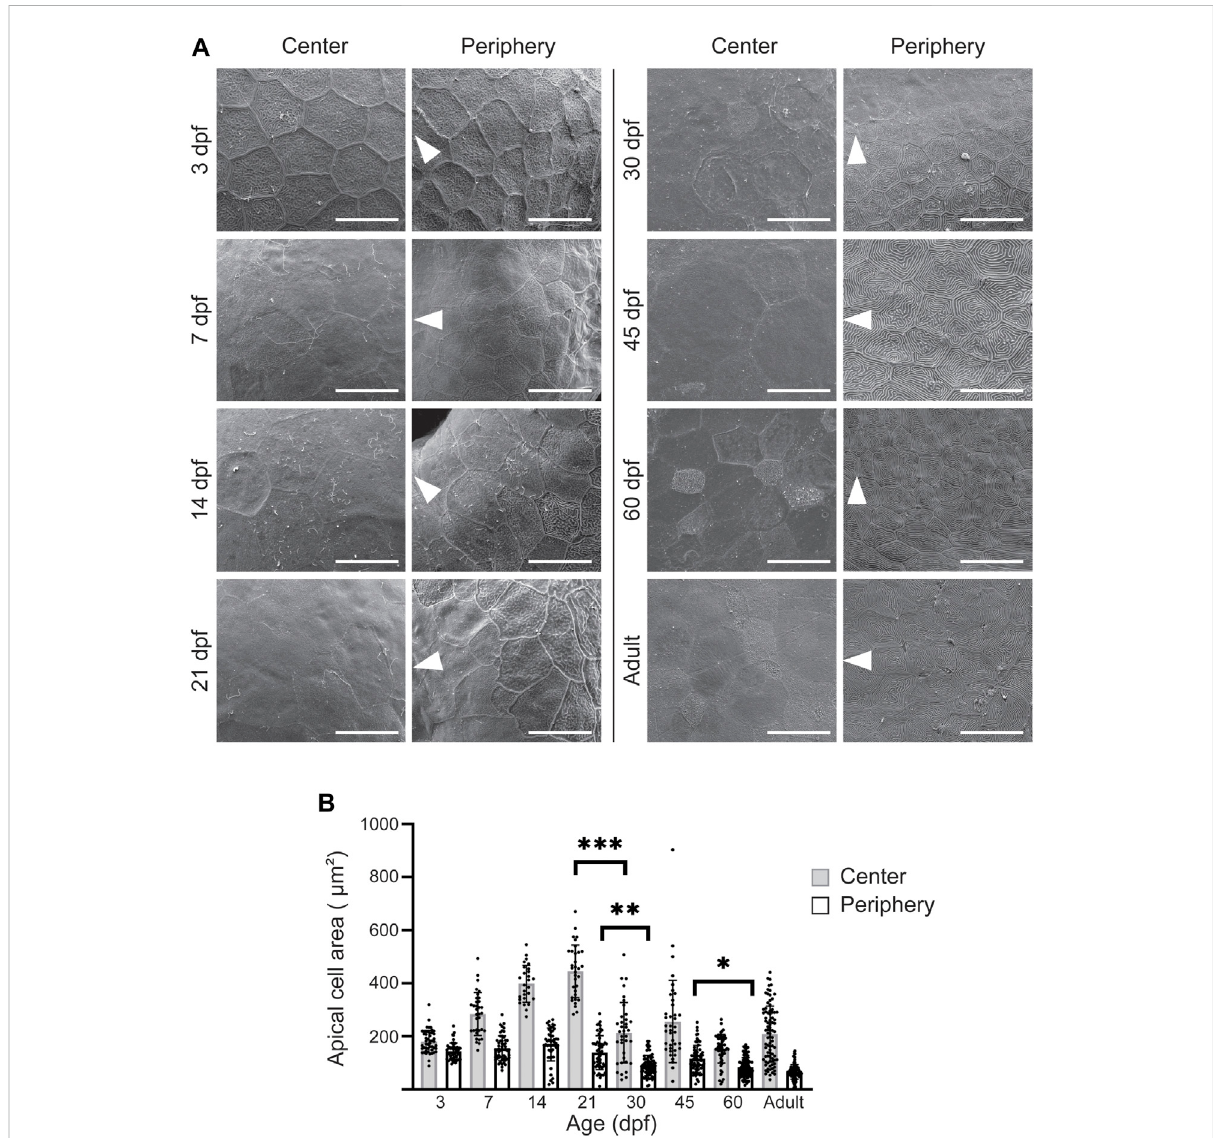
Apical cell appearance on zebra fi sh cornea. (A) Representative images of the central and peripheralregions. The white arrowheads point to the center of the eye. Scale bars: 20 µm. (B) Quanti fi cation of the apical cell area on central (gray) and peripheral (white) cornea. Cells from 3 eyes from 3 animals were pooled per age group for analysis (n = 27 – 87 in center, 47 – 121 in periphery, Kruskal-Wallis test with Dunn ’ s multiple comparisons test). The results represent mean ±